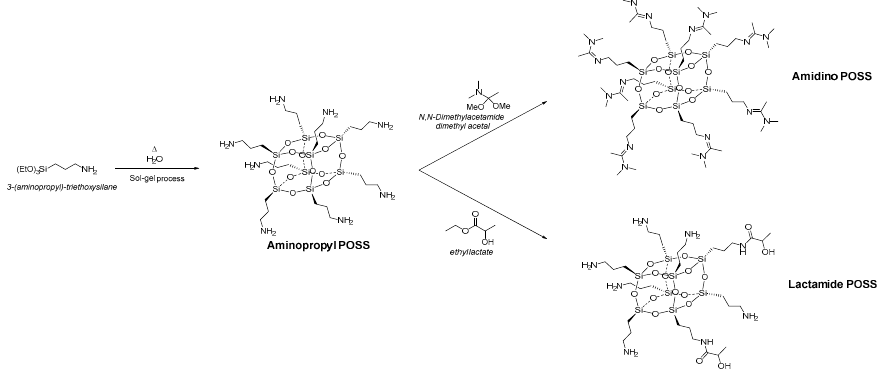
Figure 1. Synthesis of Amidino POSS ® and Lactamide POSS ® , respectively.